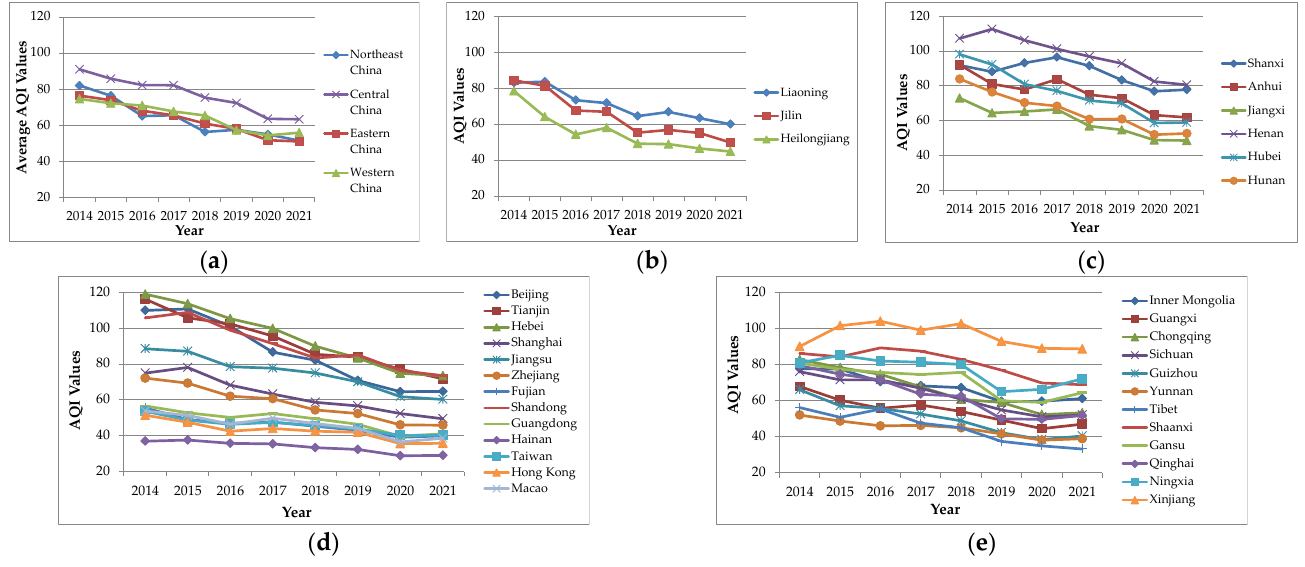
Figure 4. Change trend of AQI in each province from 2014 to 2021. ( a ) Change trend of average AQI values in northeast China, central China, eastern China, and western China; ( b ) change trend of AQI values of each province in northeast China; ( c ) change trend of AQI values of each province in central China; ( d ) change trend of AQI values of each province in eastern China; ( e ) change trend of AQI values of each province in western China.